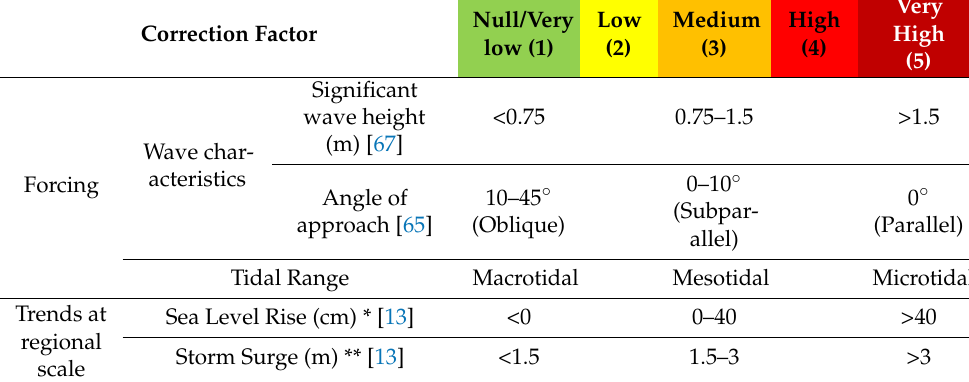
Table 5. Correction Factor: forcing variables and